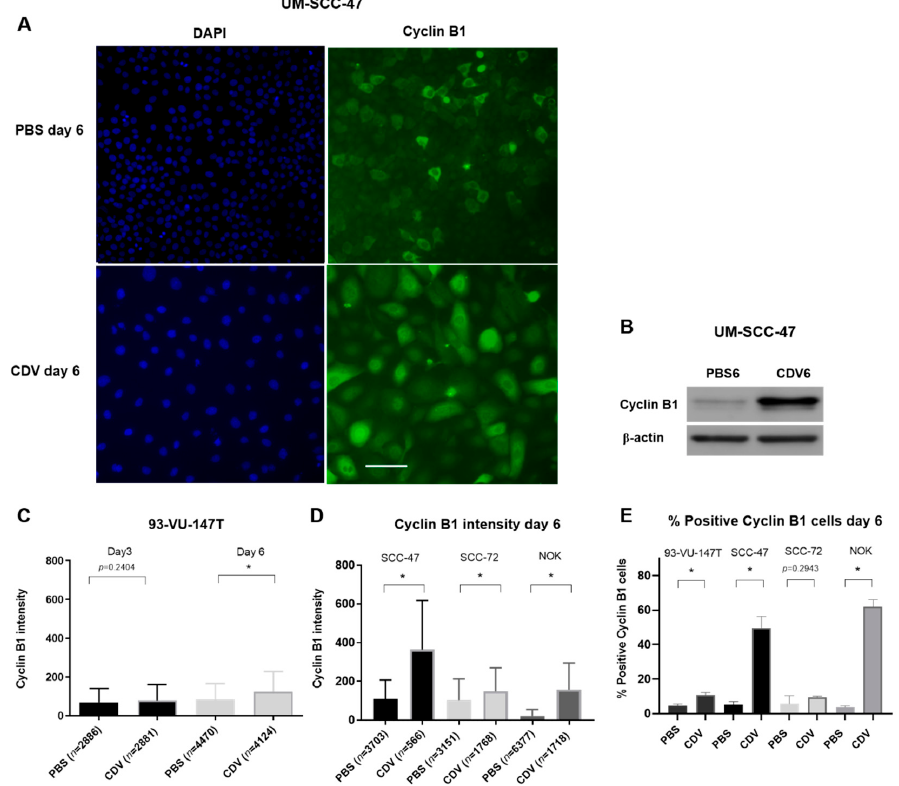
Figure 5. Upregulation of cyclin B1 expression in the nucleus after treatment of cell lines with CDV. The cells were treated for 3 and 6 days with the IC 50 value of CDV followed by cyclin B1 immunofluorescence staining. Nuclei were considered positive if the intensity was higher than the average intensity plus two times standard deviation of the negative control. ( A ) Representative images of cyclin B1 immunofluorescence (right side) of the HPV-positive UM-SCC-47 cell line after 6 days CDV treatment vs. PBS control, left side showing blue nuclear DAPI staining. ( B ) Cell lysates of UM-SCC-47 were examined by western blotting of cyclin B1 after 6 days. β -actin was used as loading control. ( C ) cyclin B1 intensity of 93-VU-147T after 3 and 6 days of treatment. ( D ) cyclin B1 intensity of UM-SCC-47, UPCI-SCC-72 and NOK after 6 days of treatment. ( E ) % positive cyclin B1 cells of 93- VU-147T, UM-SCC-47, UPCI-SCC-72 and NOK after 6 days treatment. n = number of analyzed cells. Statistical significance was indicated as follows: p < 0.05 (*). The experiments were performed in triplicate. Scale bar of ( A ): 100 µm. In order to assess if cells go into apoptosis under CDV treatment, we performed an Annexin-V assay. First, all cell lines were treated with 1 µM Staurosporine for 1 day, a known inducer of apoptosis. In the three HNSCC cell lines there was a strong increase of apoptotic cells observed, whereas only a slight increase was observed in the NOK cell line. In contrast, after CDV treatment there was no increase in apoptotic cells observed in the HNSCC cell lines, except for the 93-VU-147T, showing a significant increase of apoptotic cells after CDV treatment, but this was an increase of 2.7%. The NOK cell line showed a strong increase in apoptotic cells. Taken together, CDV induced apoptosis in the NOK cell line, but not in the HNSCC cell lines (Figure 6).